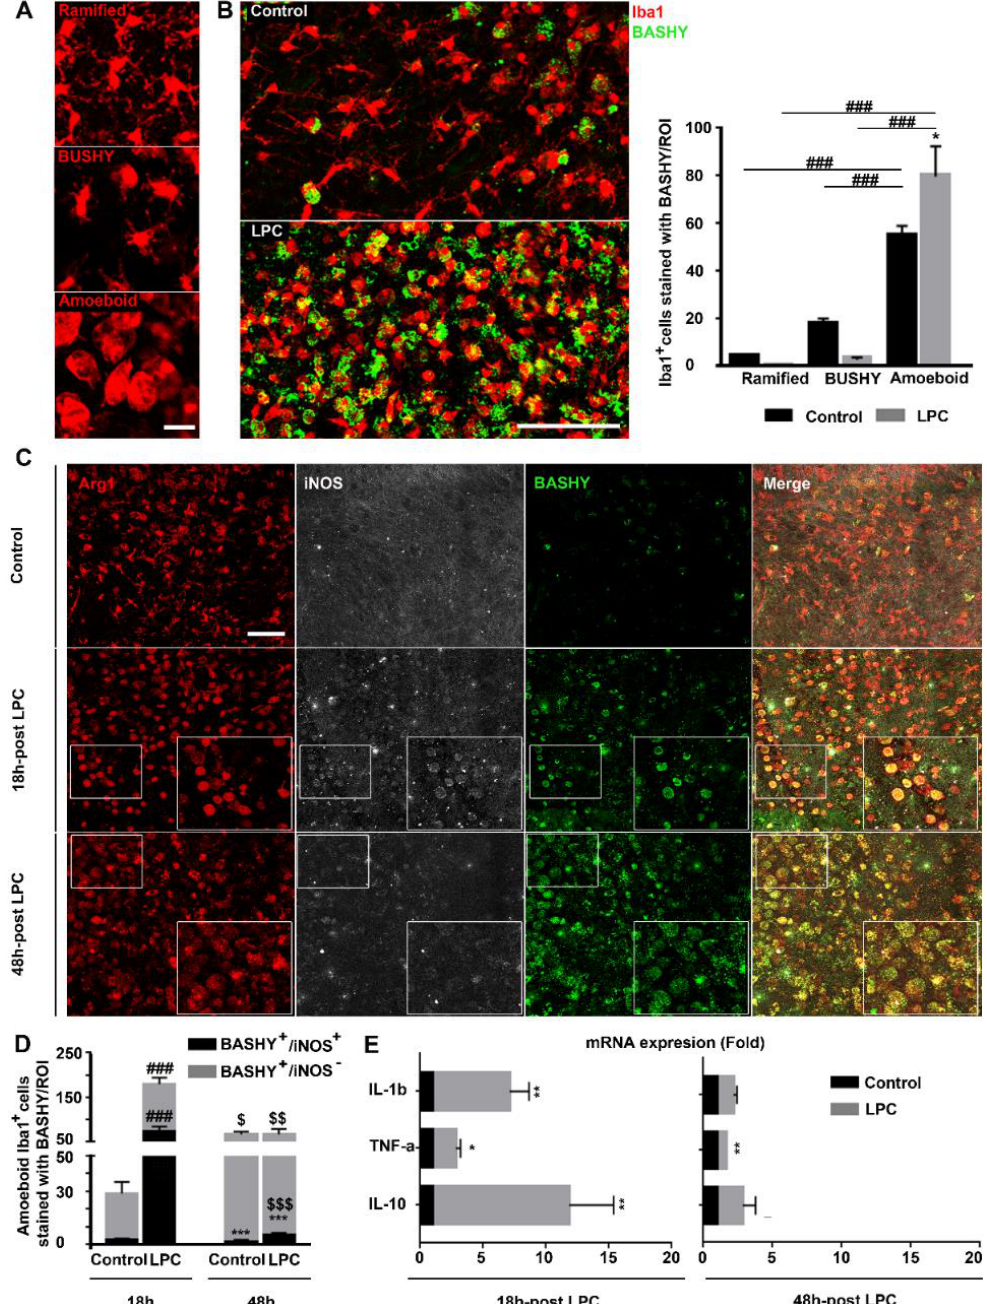
Figure 3. BASHY selectively targets amoeboid phagocytic Iba1 + cells after demyelination. ( A ) Representative images of differential macrophage/microglial (Iba1, red) morphologies, including ramified, bushy, and amoeboid morphologies, imaged in the cerebellar white matter. Scale bar equals 20 microns. ( B ) Representative images and respective quantitative analysis of organotypic cerebellar slice cultures (OCSCs), immunostained for microglia/macrophages (Iba1, red) and further labeled with BASHY dye (BASHY, green) to observe cell morphological changes over demyelination and BASHY preference over cell morphologies, 48 h post-incubation with LPC. Scale bar equals 100 mi- crons. Results are mean ± SEM. *** p < 0.001 vs. respective control. ### p < 0.001 for amoeboid LPC vs. bushy LPC; for amoeboid LPC vs. ramified LPC; for amoeboid control vs. bushy control; and for amoeboid control vs. ramified control. Data are representative of two independent experiments. ( C ) Representative images from the cerebellar white matter of control and LPC-induced OCSCs at 18 h and 48 h post-induction that were immunostained to observe microglial anti-inflammatory marker Arginase (Arg1, red) and inducible nitric oxide synthase, a common marker of inflammatory micro- glia (iNOS, white), and to further assess co-localization with BASHY molecule (BASHY, green). Scale bar equals 120 microns. ( D ) Quantitative analysis of BASHY co-localization with anti-inflam- matory (iNOS-) and pro-inflammatory (iNOS + ) microglia at each time point. Results are mean ± SEM. *** p < 0.001 for BASHY + /iNOS + vs. respective BASHY + /iNOS - ; ### p <0.001 for BASHY + /iNOS + LPC vs. respective control; and for BASHY + /iNOS - LPC vs. respective control. $ p < 0.05 for BASHY + /iNOS - control 48 h vs. respective 18 h; $$ p < 0.01 for BASHY + /iNOS + LPC 48 h vs. respective 18 h; and $$$ p < 0.001 for BASHY + /iNOS + LPC 48 h vs. respective 18 h. Data are representative of two independent experiments. ( E ) mRNA expression of pro-inflammatory (IL- 1β and TNF - α) and anti - inflammatory (IL-10) cytokines in control and LPC-induced OCSCs at each time point. Results are expressed as mean ± SEM. * p < 0.05, ** p < 0.01 vs. respective control.